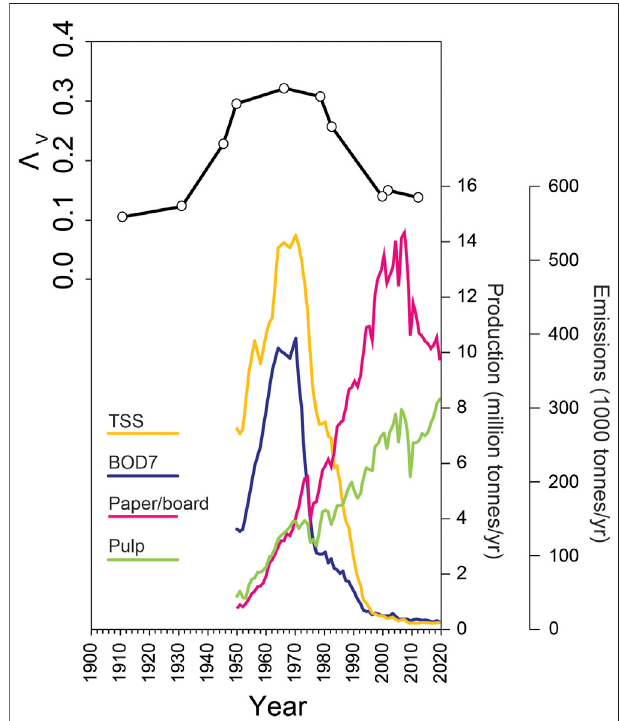
FIGURE 5 | Time series of production and emissions from forest industries in Finland since 1950 (https://www.forestindustries. fi /statistics/ environment/), compared with the dated sediment record of total vanillyl phenols, reported as mg/100 g C ( Λ V ). TSS (cid:2) total suspended solids, BOD 7 (cid:2) 7 th day biological oxygen